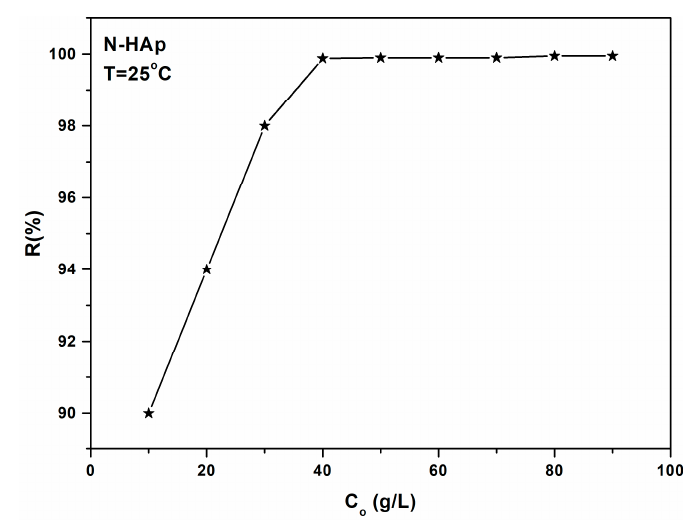
Figure 3. The effect of the initial concentration of Pb 2+ on the N-HAp efficiency in the removal of lead ions from aqueous solutions.